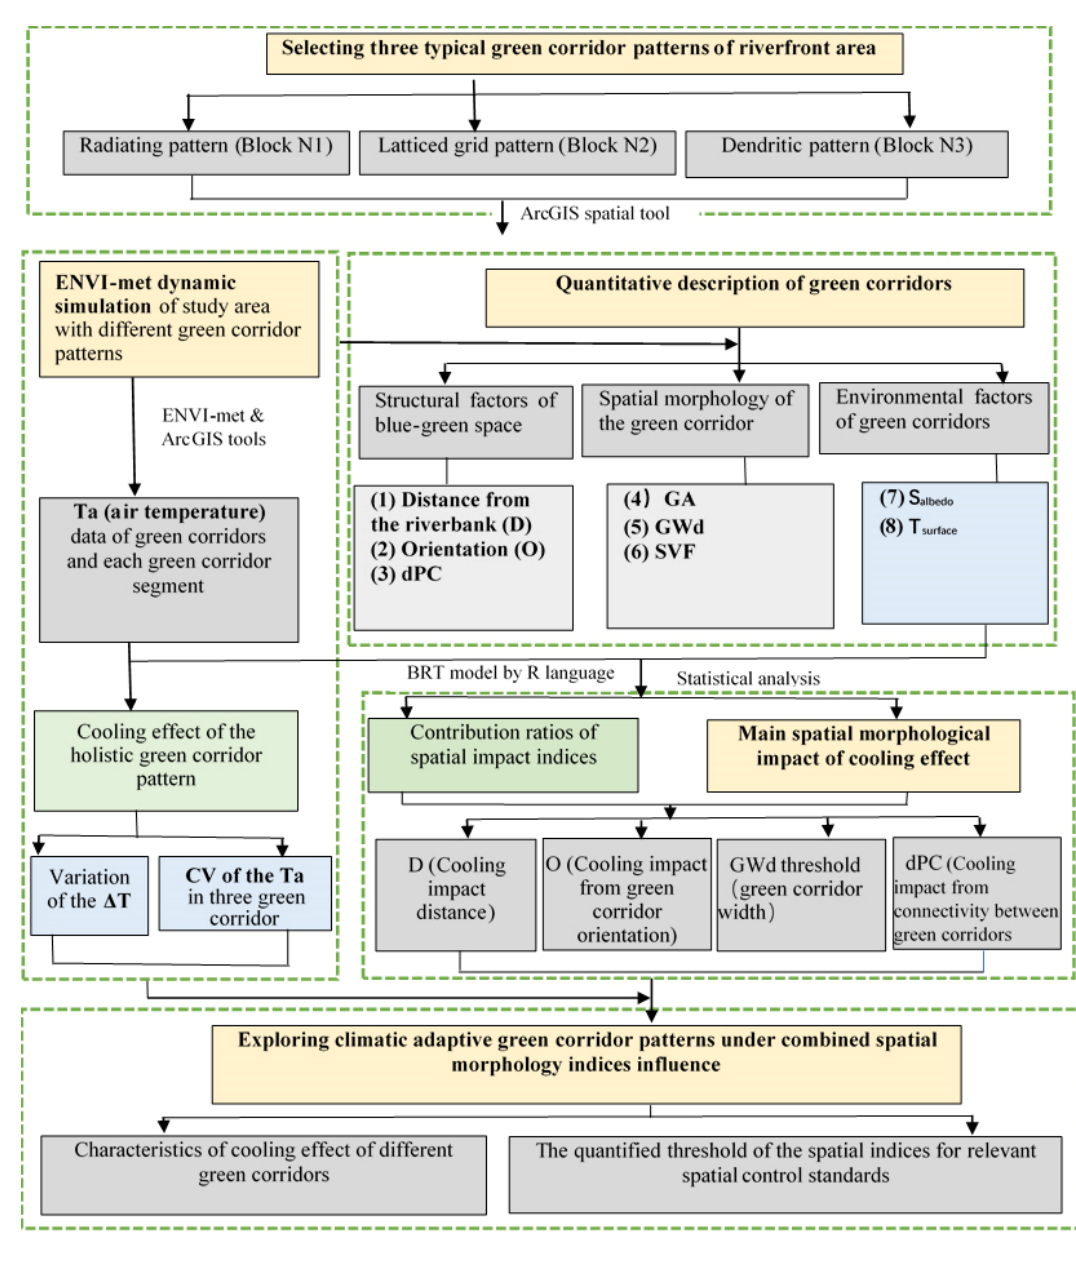
Figure 4. Flow chart of the overall study.